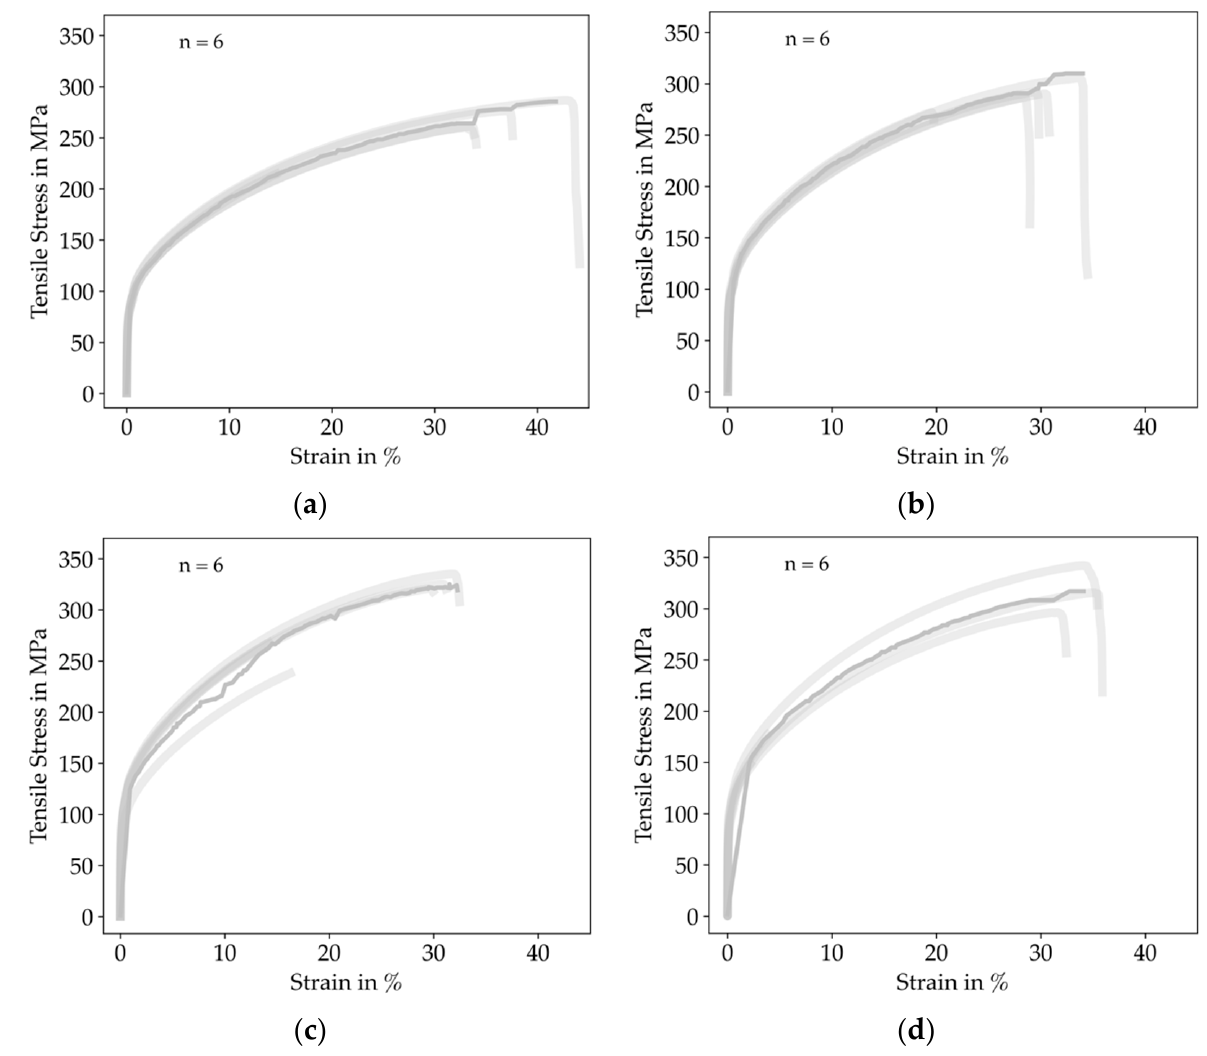
Figure 10. Resulting stress-strain curves of all tensile specimens clustered by infill degree. The solid line represents a mean-curve computed by rigid regression, the shaded lines represent the single measurements: ( a ) ID 25; ( b ) ID 50; ( c ) ID 75 and ( d ) ID 100. High deviations for the elongation at break were observed for all specimens.